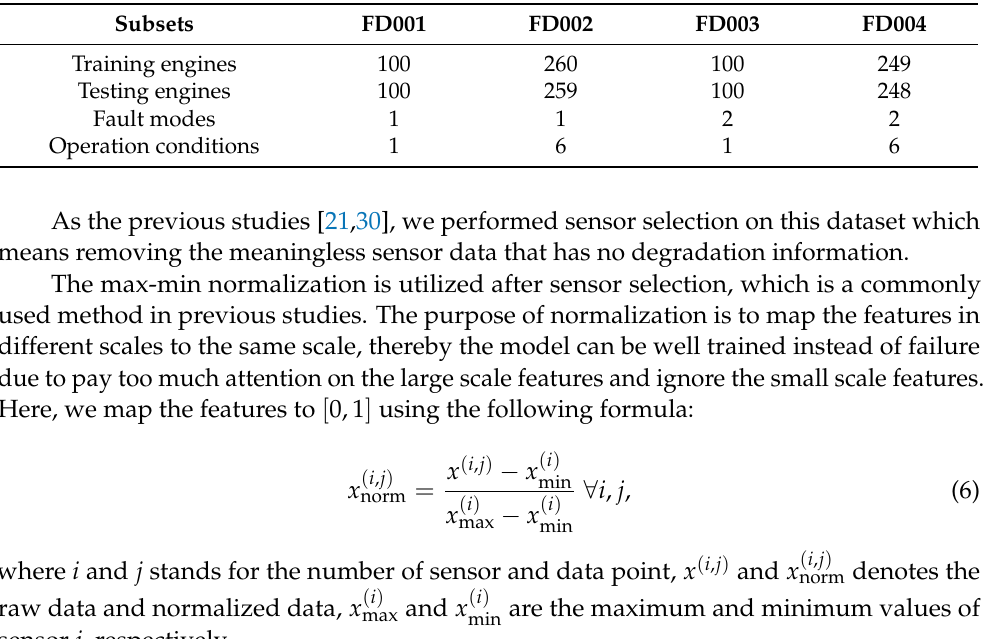
Table 1. The details of C-MAPSS dataset